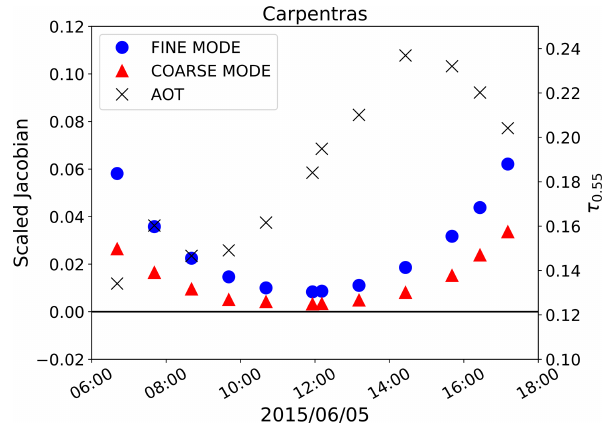
Figure 8. Scaled AOT Jacobians (left y axis) associated with SE- VIRI observation in the VIS0.6 band over Carpentras, France, for 5 June 2015. The blue dots represent the fine mode, the red triangles the coarse mode. The black crosses represent the retrieved AOT at 0.55µm (right y